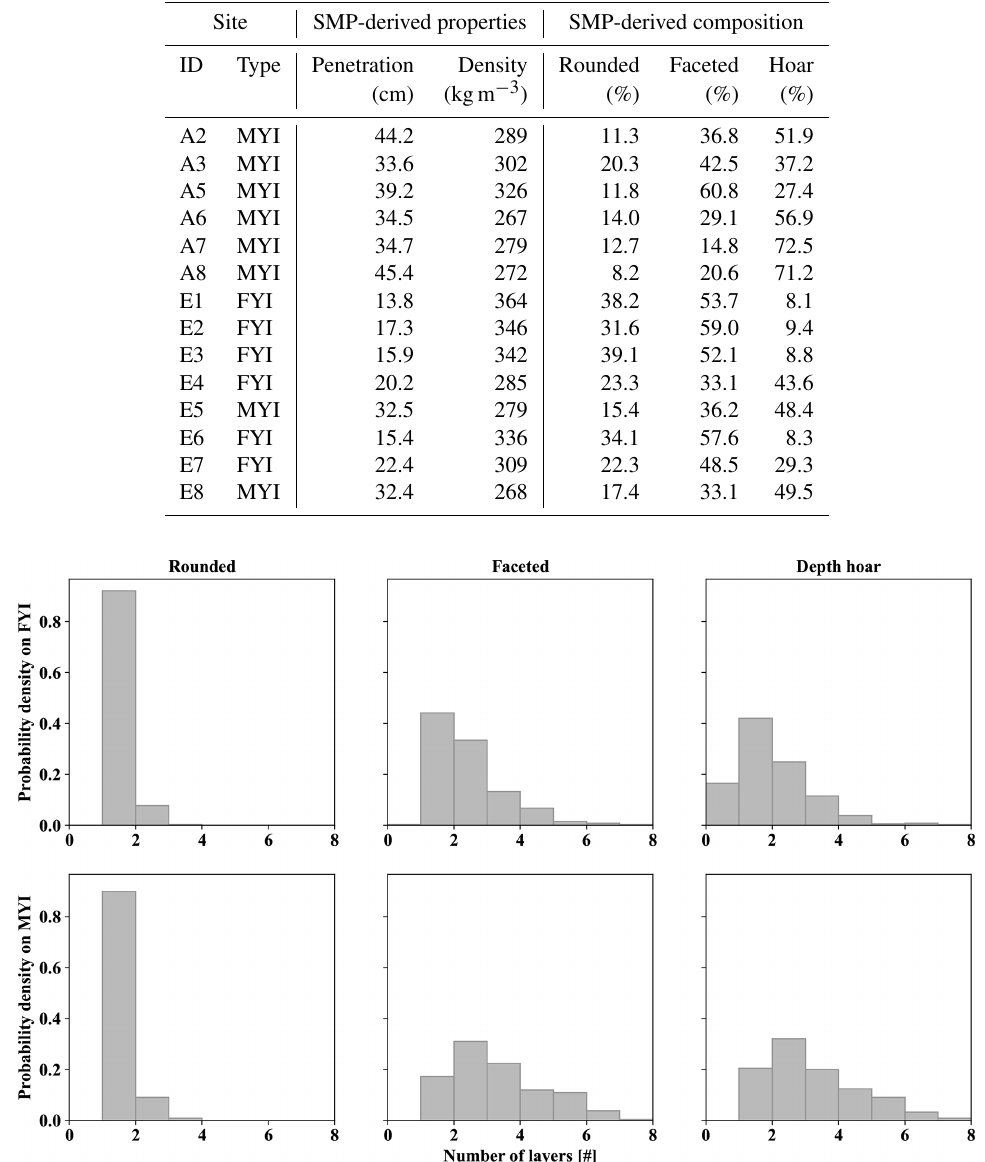
Table 5. Snow density and layering derived from SMP profiles at each field campaign site using Eq. (1) and the automated classification procedures described in Sect. 3.4.